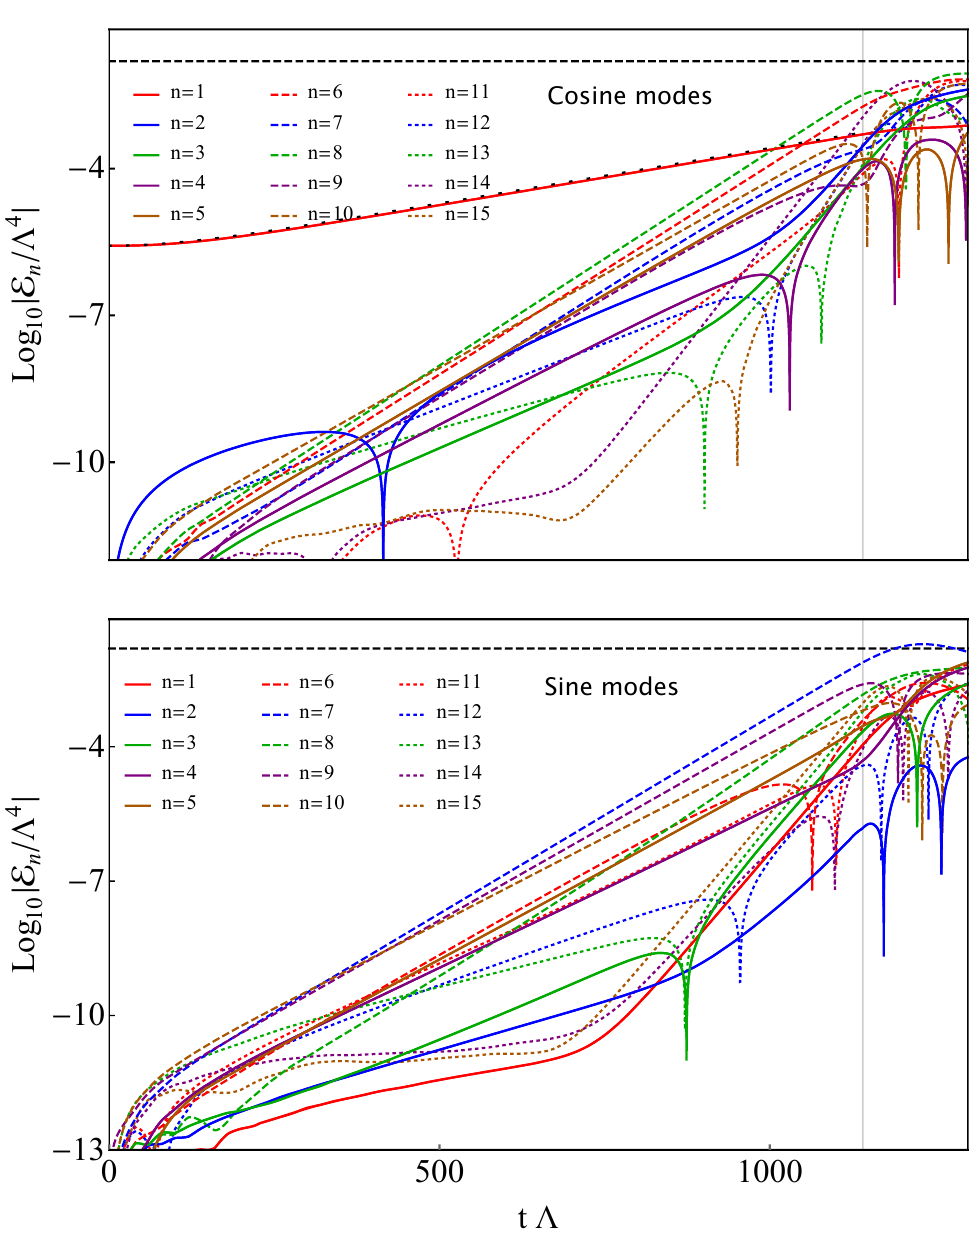
Figure 5 . Time evolution of some cosine (top) and sine (bottom) Fourier modes of the energy density shown in (cid:12)gure 4(left). The dashed horizontal lines at the top indicate the average energy density or, equivalently, the n = 0, constant mode. The grey vertical lines at t (cid:3) = 1141 indicate the end of the linear regime. A snapshot of the energy pro(cid:12)le at this time is shown in (cid:12)gure 8(left) in solid blue. The black dots on top of the n = 1 line in (top) correspond to the analytical solution for the sound mode in the linear regime, namely to the sum of one growing and one decaying exponential with exponents given by